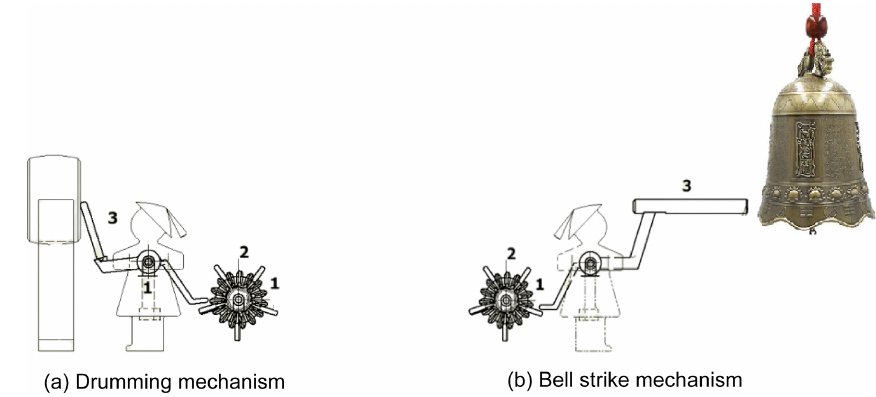
Figure 21. Atlas of feasible specialized chains for the time-reporting